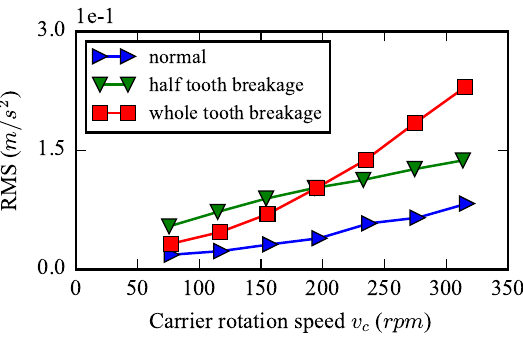
Figure 12. RMS of the experimental ring vertical acceleration varying with rotational